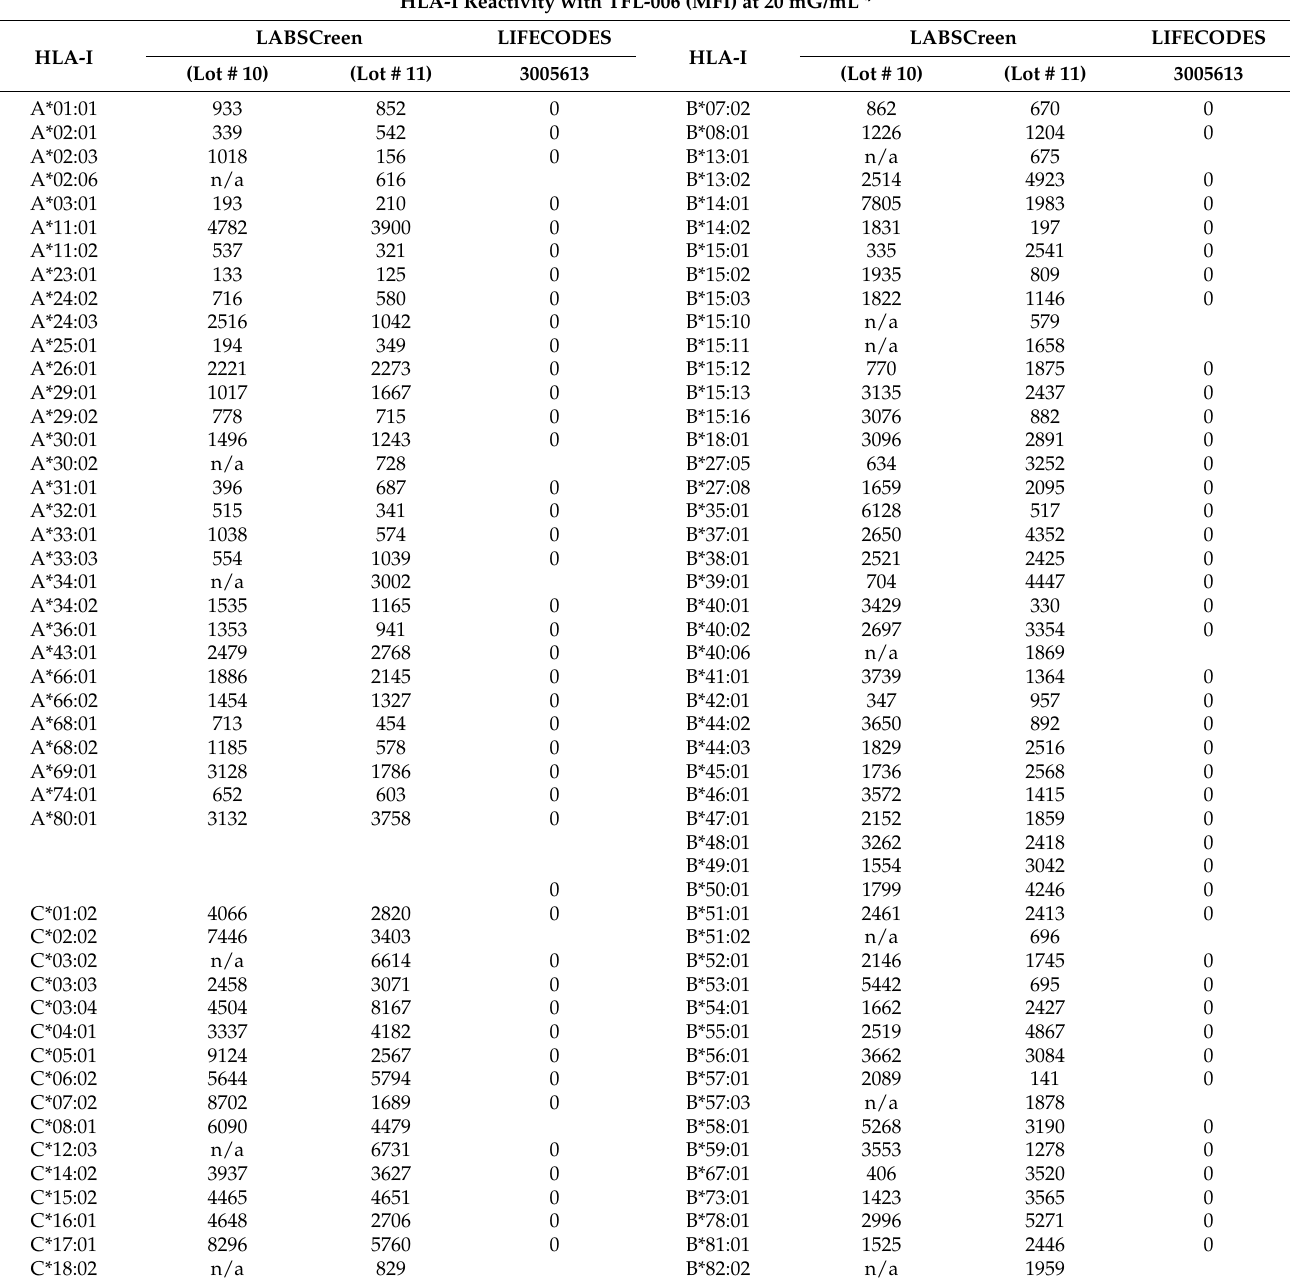
Table 10. TFL-006 fails to recognize HLA antigens coated on LIFECODES beadsets as they contain only intact HLA (closed